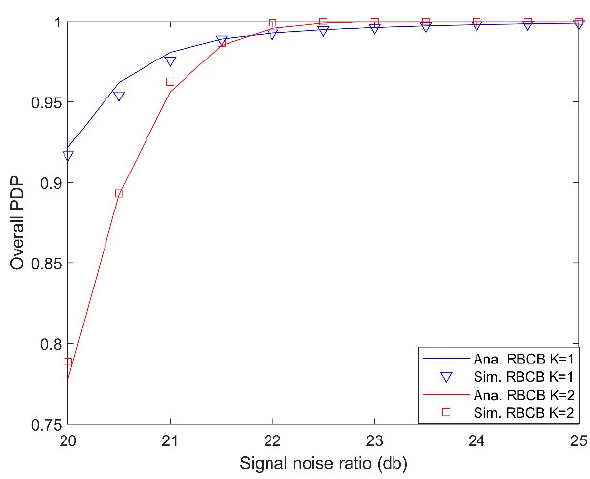
Figure 13. Comparison of PDP for once broadcasting.